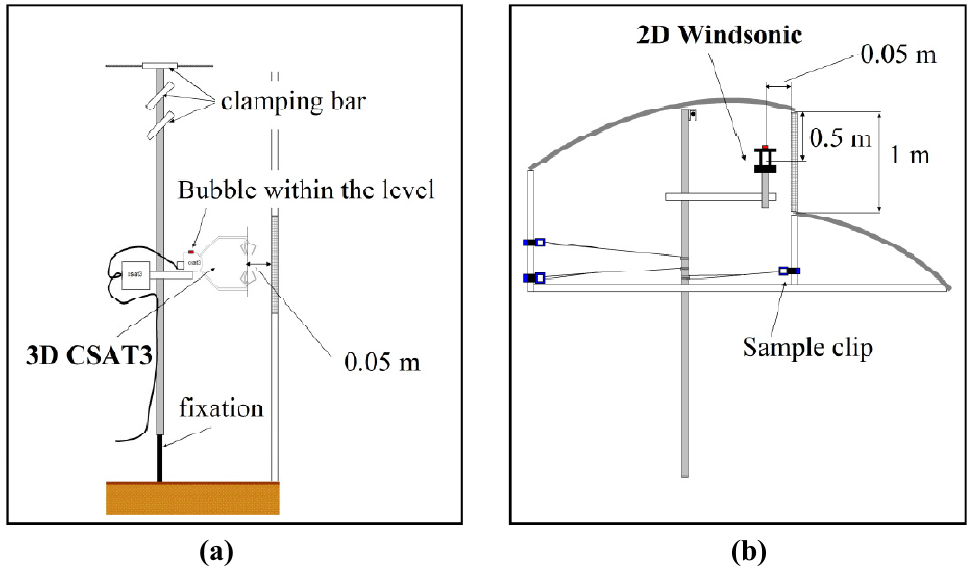
Figure 3. Details of the experimental setup using 3D anemometers placed at the side vents ( a ) and 2D anemometers at the roof vent ( b